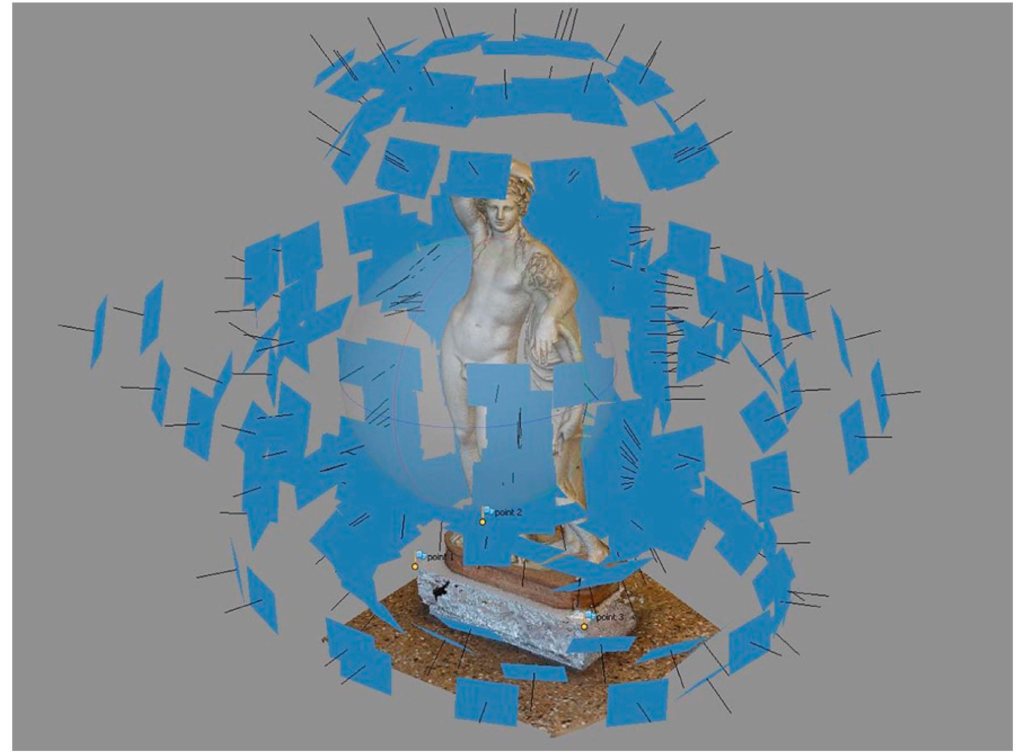
Figure 10. The photogrammetric